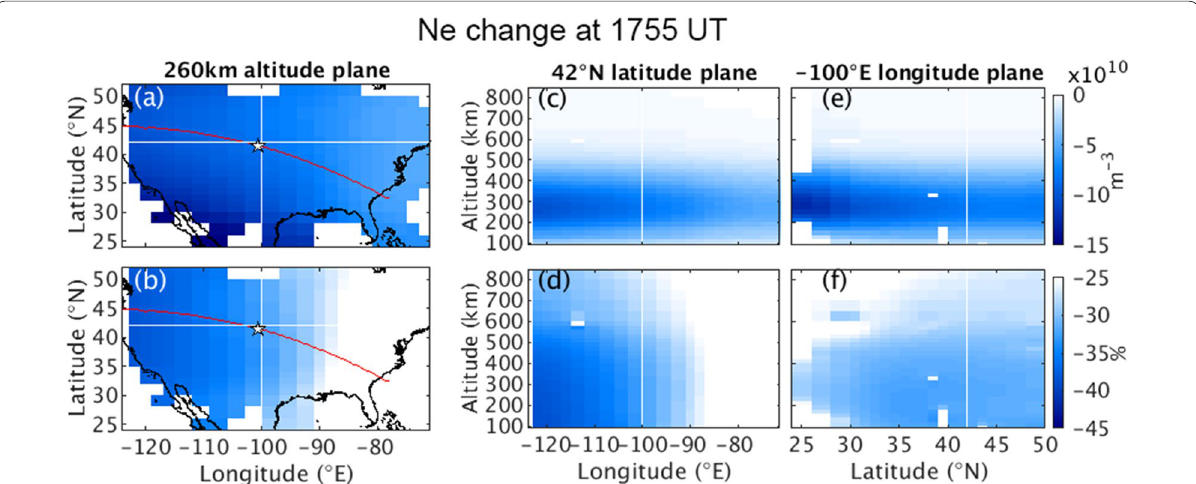
Fig. 3 The electron density variations as well as the difference percentage at 1755 UT at 260 km altitude plane ( a – b) , 42 o N latitude plane ( c – d) , and 100 o E longitude plane ( e – f ). The electron density difference in a , c , and e is calculated by Ne d -Ne d-1 . The electron density difference percentage in − b , d , and f is calculated by Eq.